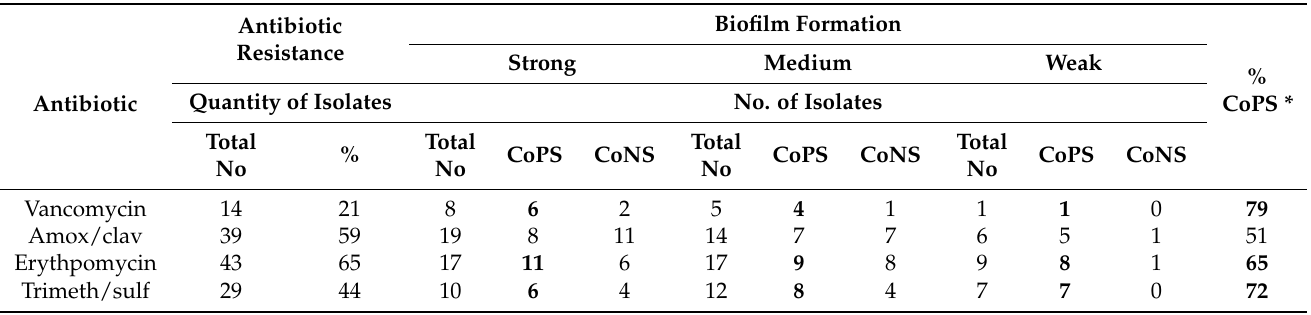
Table 6. The association between antibiotic resistance, biofilm formation and biochemical pattern (CoPS or CoNS) in Staphylococci spp. isolates collected from medical